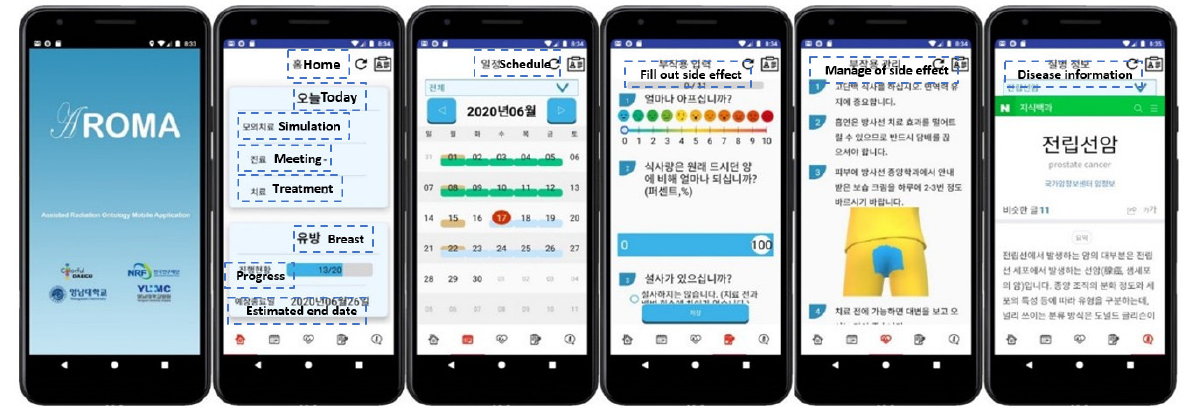
Figure 6. Overall structure of the mobile application.